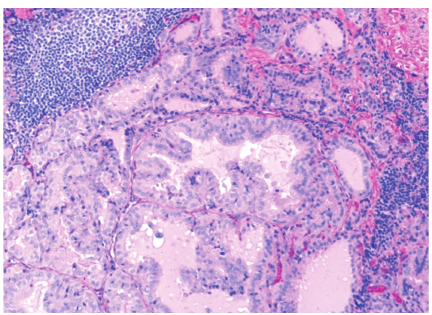
Figure 13: Graves disease: there is follicular hyperplasia with intra- cellular colloid droplets, cell scalloping, a reduction in follicular colloid, and a multifocal lymphocytic infiltrate (hematoxylin-eosin, original magnification ×